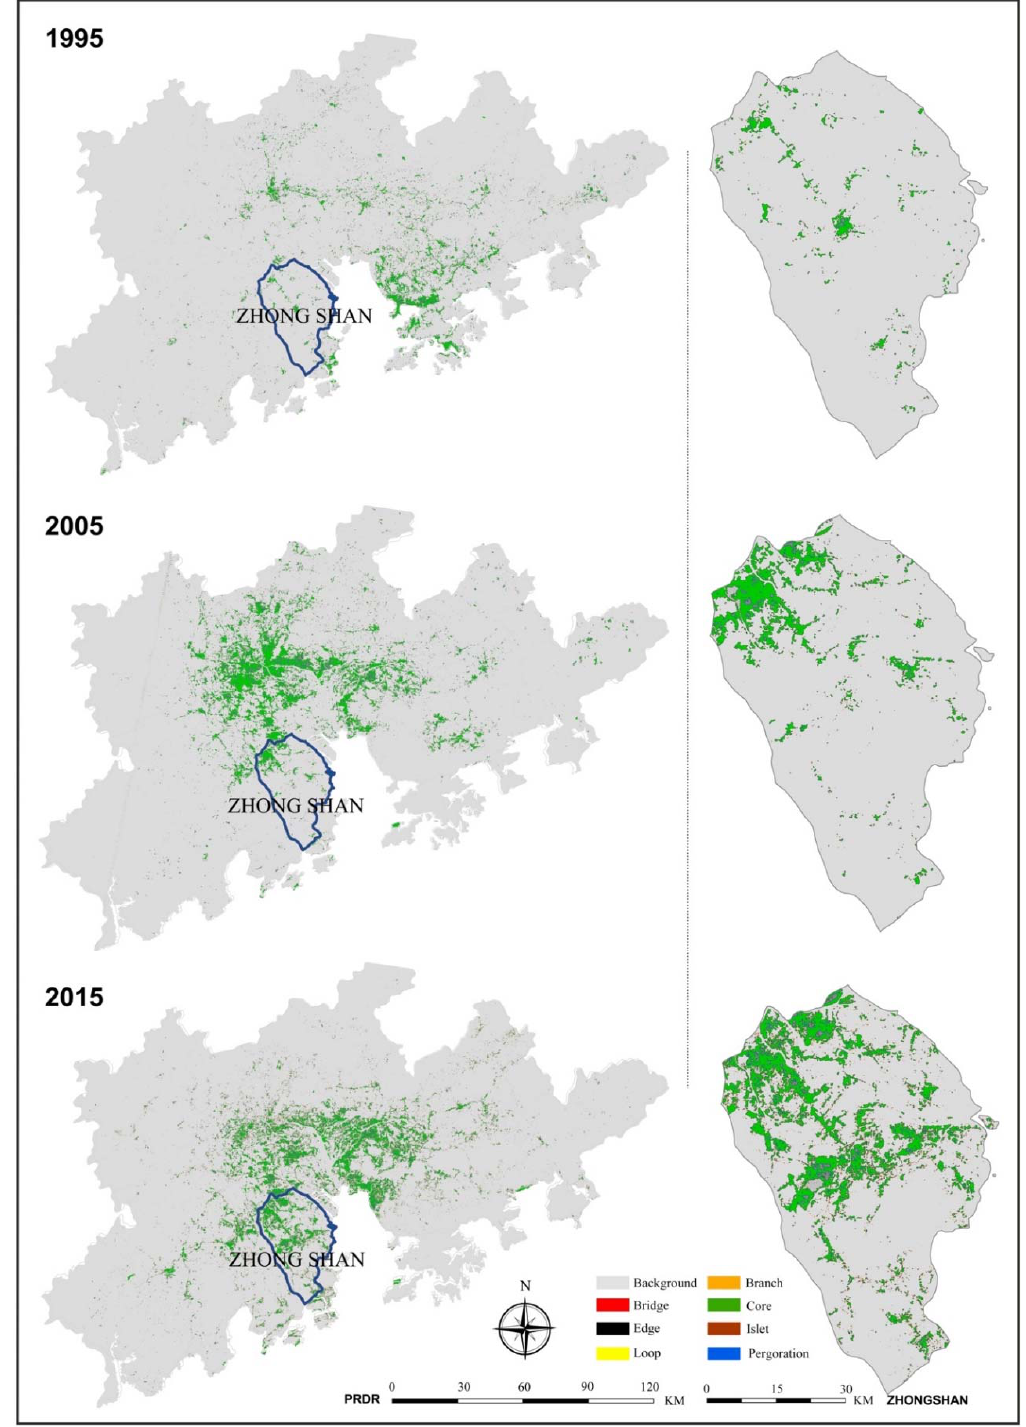
Figure 5. Results of the MSPA-based surface UHI patch classification from 1995 to 2015 in the PRDR and specifically for Zhongshan City (for detailed enlarged maps, please see the Supplementary Materials).